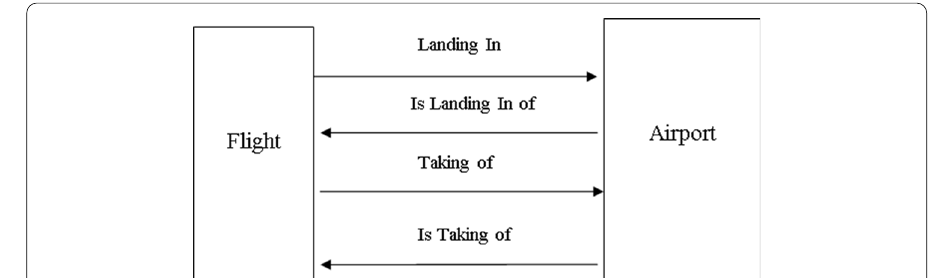
Fig. 13 Example of single-function binary connection diagram